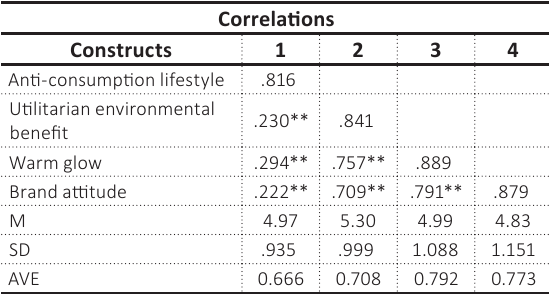
Table 1. Mean, standard deviation and correlations